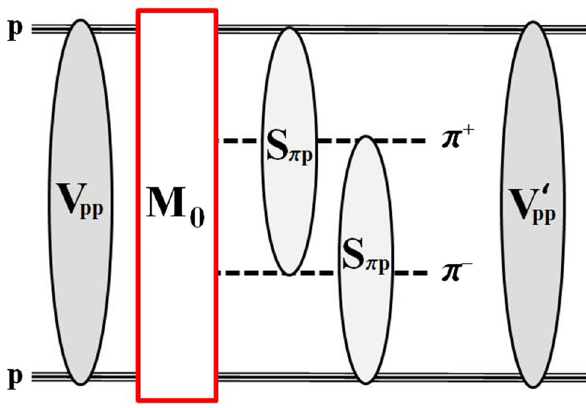
Fig. 2 Full unitarized amplitude of the process of double-pion LM CEDP p + p → p + π + + π − + p . Proton–proton rescatterings in the initial and final states are depicted as V pp and V (cid:3) pp blobs, respectively, and pion–proton rescattering corrections are also shown as S π p blobs. The sum of primary amplitudes M 0 from Fig. 1 is shown as a red rectangle